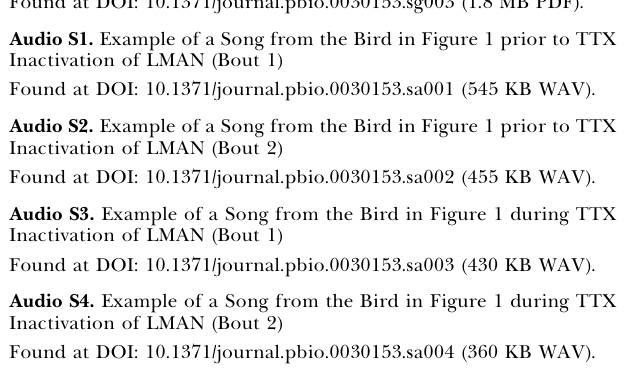
Figure S2. Dose- and Distance-Dependent Effects of TTX Injections in and around LMAN (A) Decrease in acoustic variability ( D V) approximately 1 h after injection, as a function of location and concentration of TTX injections. Red bars indicate dose response for TTX injections in LMAN ( n = 2 birds; 8 syllables; injection sites for the two birds correspond to the blue and grey markers in Figure S1). Blue bars indicate 30-nl saline injections in LMAN ( n = 2 birds; 7 syllables). Green bars indicate 30-nl (50 l M) TTX injections 1.25 mm medial (MMAN, n = 2 birds; 6 syllables) and dorsal ( ‘‘ above, ’’ n = 2; 8 syllables) from the center of LMAN. (B and C) Summary of experiments done to verify the physiological spread of TTX. Experiments were done in anesthetized birds (2% isoflurane). A bipolar stimulating electrode was placed in RA, and a recording electrode in LMAN, producing antidromically evoked activity in LMAN (stimulus pulses, 175 l A, 0.2 ms, 0.5 Hz ). TTX (30 nl, 50 l M) was injected at different distances away from the recording electrode. (B) Examples of recorded signals for TTX injections 400 l m (top) and 1,250 l m (bottom) away from the recording electrode (averaged over 30 stimulus pulses). The baseline stimulus artifact recorded 1 mm above LMAN is shown in the green boxes (left). Signal recorded in LMAN immediately before injection is shown in the black boxes (middle). Signal recorded 1 h after injection is shown in the red boxes (right). (C) Summary of evoked activity 1 h after TTX injections made at different distances away from the recording site. Evoked activity was measured as the root-mean- squared deviation of the signal from the baseline in the interval 1.5– 4.5 ms after the stimulation pulse (six birds, two at 400 l m, two at 600 l m, and one each at 800 l m and 1,250 l m). Found at DOI: 10.1371/journal.pbio.0030153.sg002 (1.1 MB PDF). Figure S3. Example of a Juvenile Zebra Finch Song (54 dph) Showing a Loss of Sequence and Acoustic Variability following LMAN Inactivation by TTX Injection The song snippets shown are from three consecutive song bouts, immediately before and 1 h after TTX injection. Tutor song is